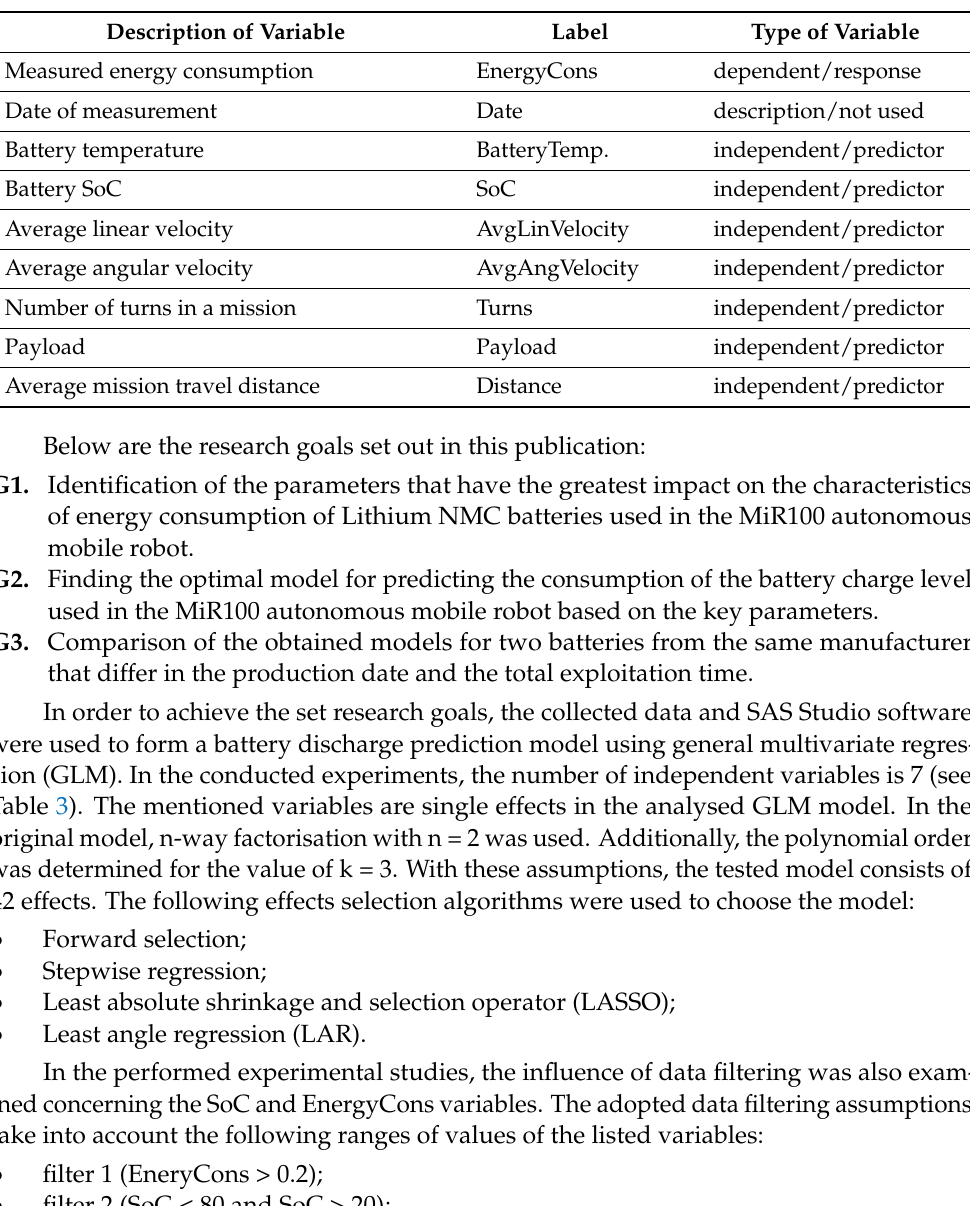
Table 3. Description of variables and their